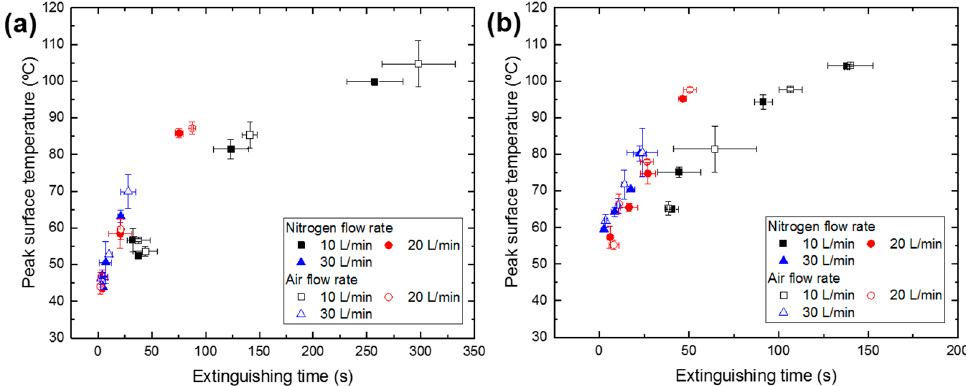
Figure 12. Extinguishing time vs. peak surface temperature for atomizing gas type effect (note that the scales of x -axis in both figures are different): ( a ) HRR = 1.17 kW and ( b ) HRR = 5.23 kW.